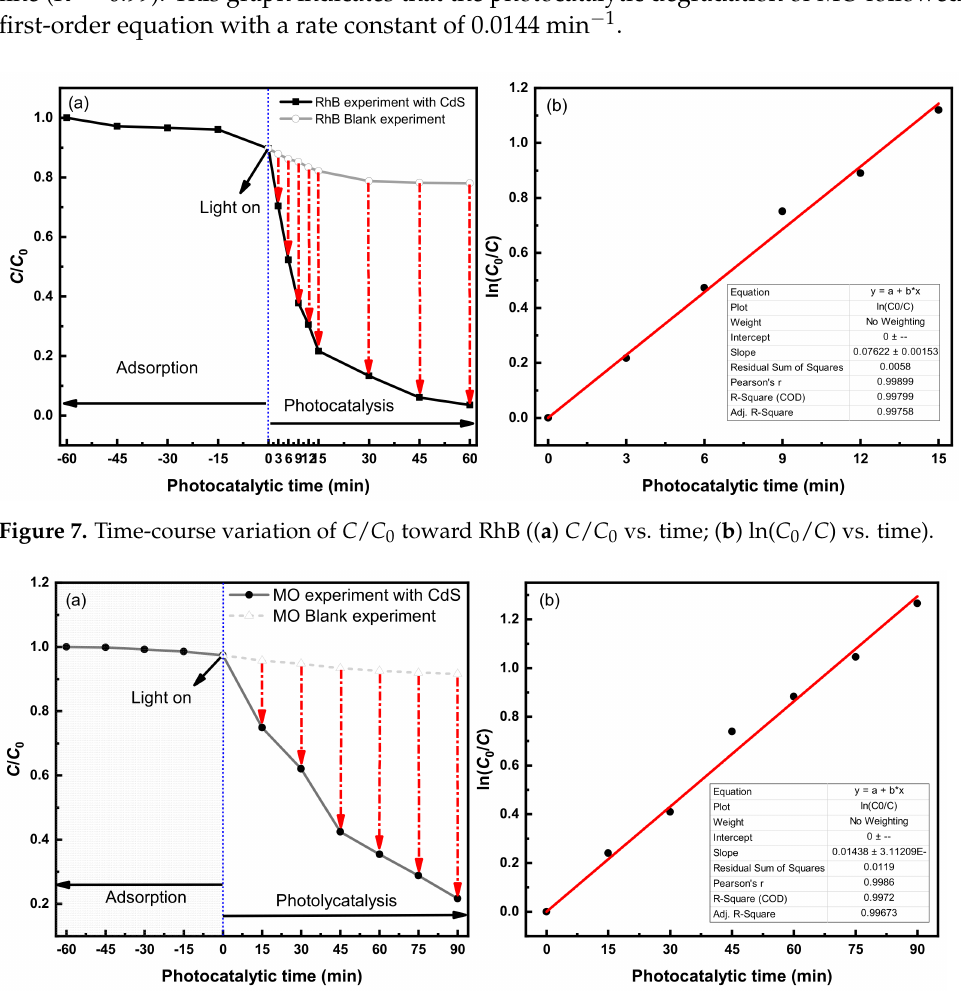
Figure 8. Time-course variation of C / C 0 toward MO (( a ) C / C 0 vs. time; ( b ) ln( C 0 / C ) vs.